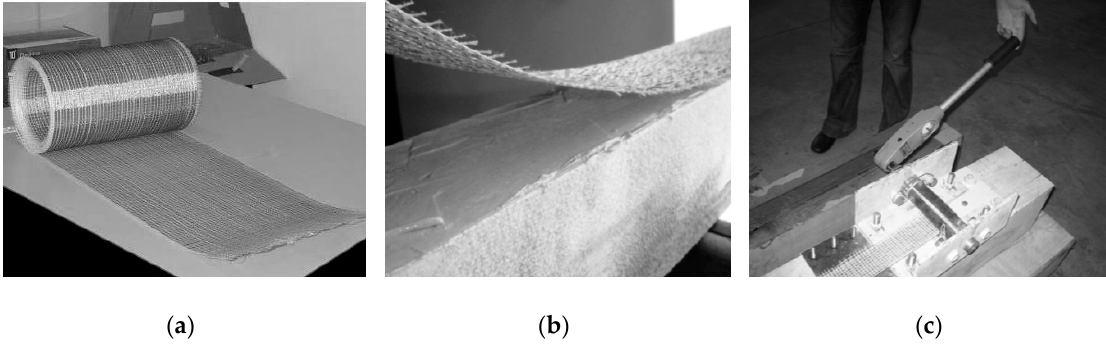
Figure 23. Use of steel cords: ( a ) steel-fiber coil, ( b ) application of the cords using an epoxy paste, ( c ) pre-stressing device. Reproduced from [66], with permission from Elsevier, 2011.